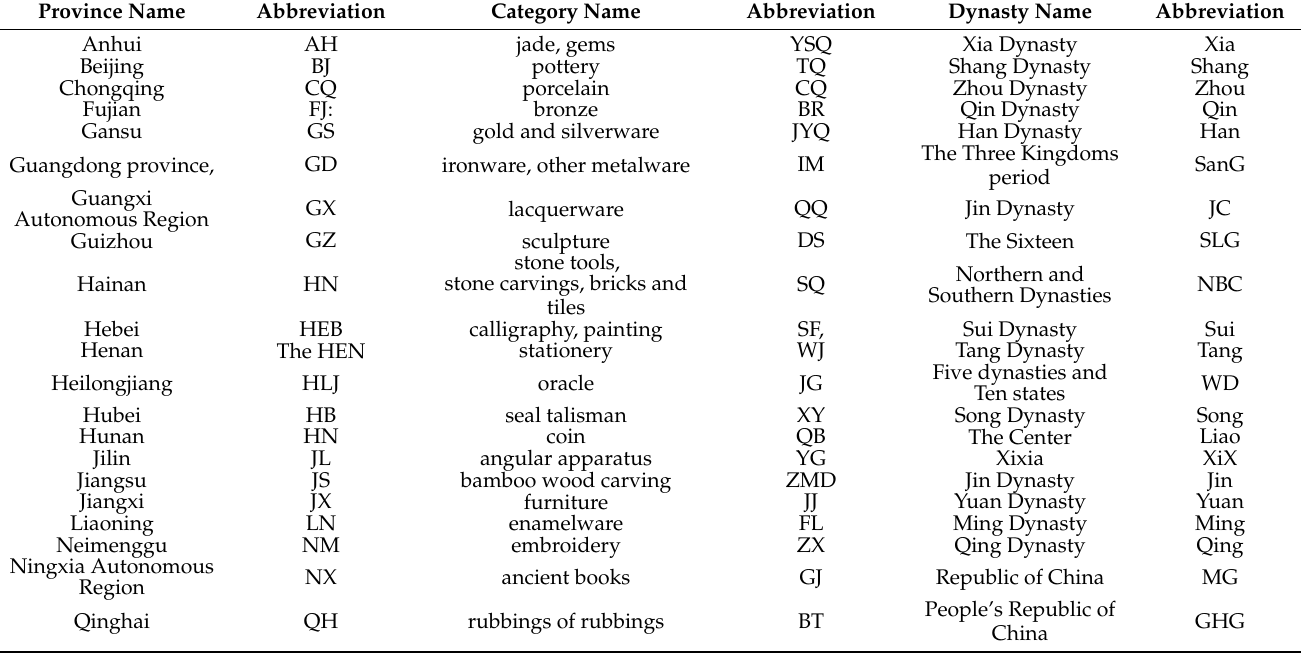
Table A1. Abbreviation of dynasty, category and